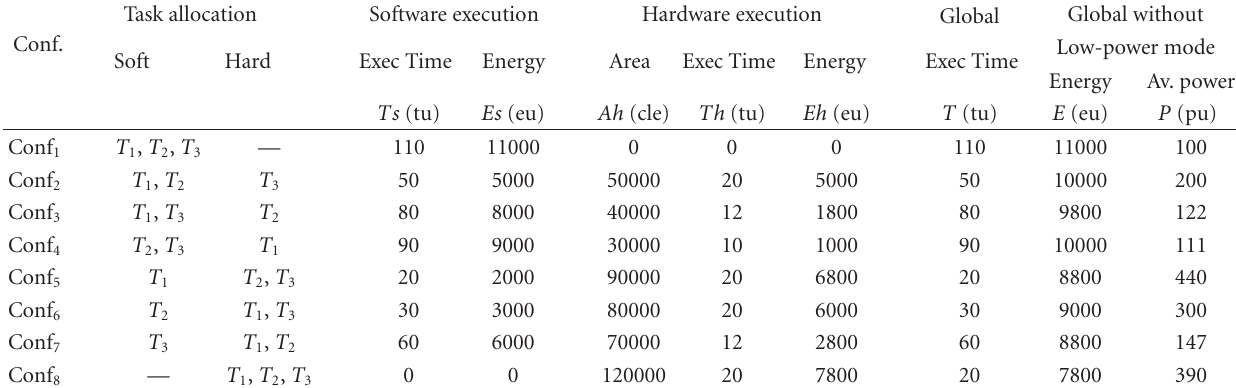
Table 3: Example of possible combinations of task allocations within the execution platform when considering that the processor can be in a low-power mode when no software task is executed. In this case, the power consumption of the processor is equal to 0.